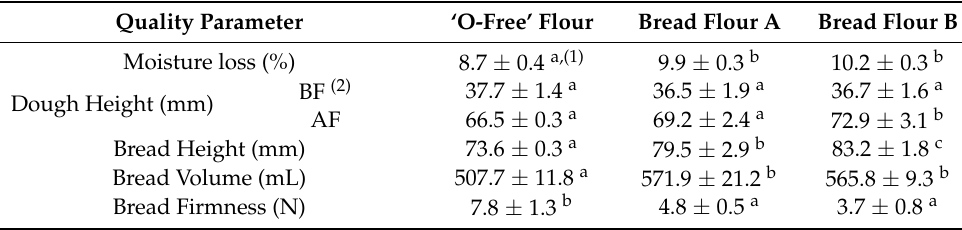
Table 3. Quality characteristics of the bread prepared with the flour samples.